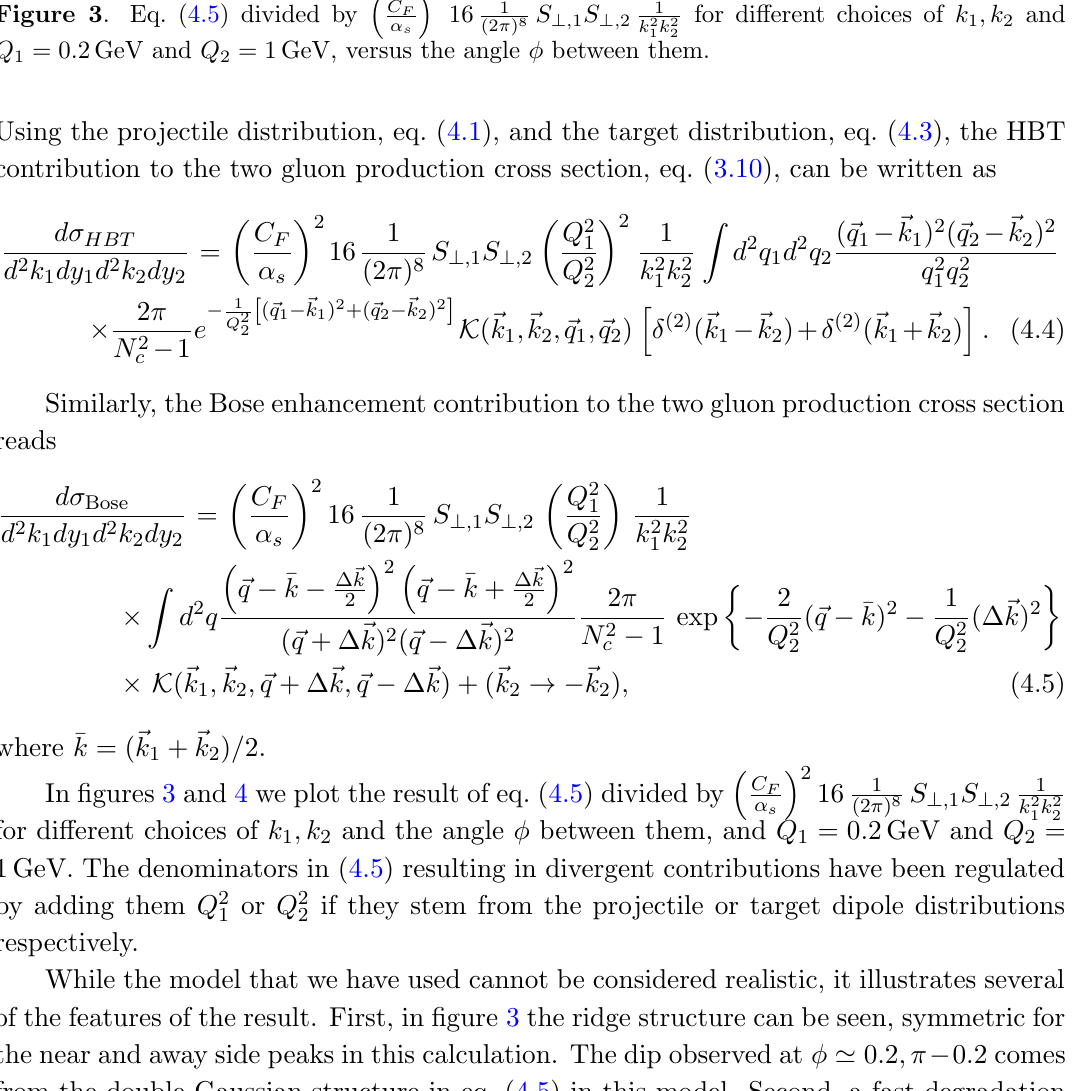
(cid:16) (cid:17) 2 C F 16 1 S ? ; 1 S ? ; 2 1 for di(cid:11)erent choices of k 1 ; k 2 and (cid:11) s k 2 1 k 2 2 (2 (cid:25) ) 8